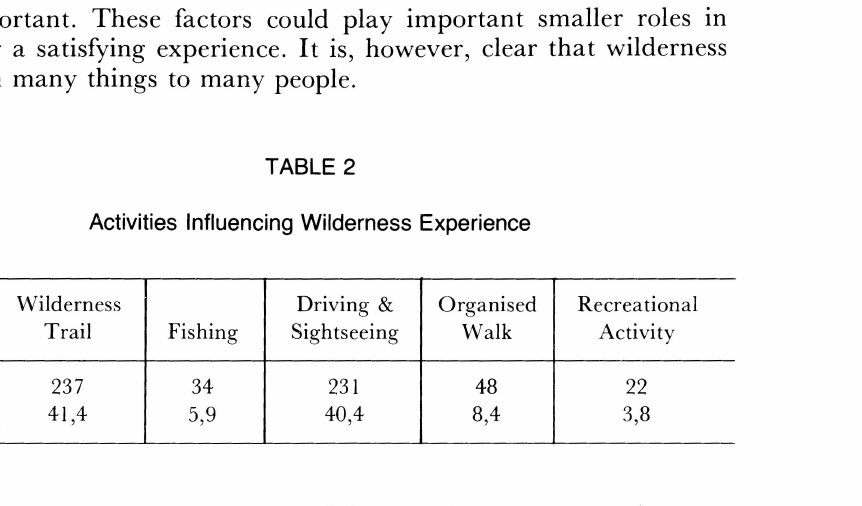
Activities Influencing Wilderness